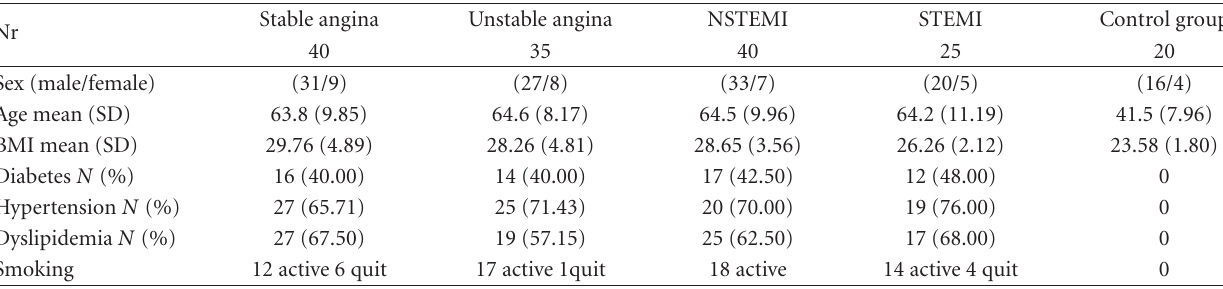
Table 1: Patient demographics and clinical characteristics.